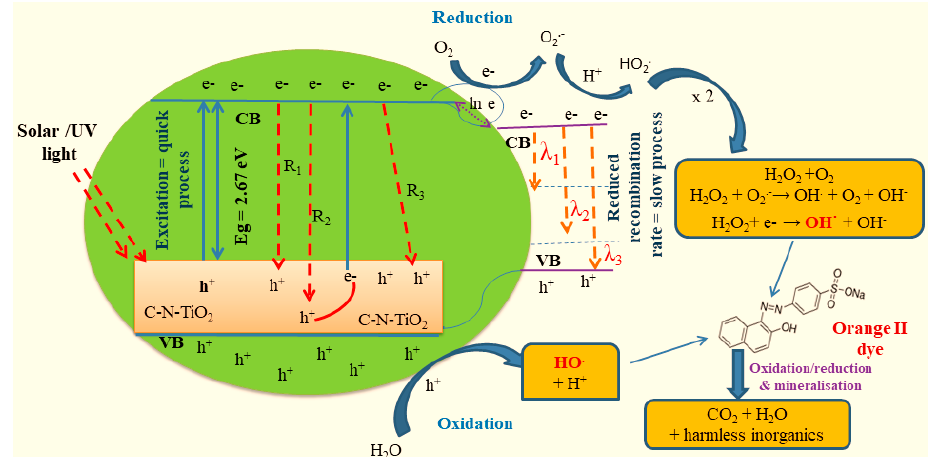
Figure 10. Schematic of photo catalytic and recombination mechanisms for the decolouration of O.II (R 1 , R 2 and R 3 = recombination mechanisms between conduction band (CB) and valence band (VB), ( λ 1 , λ 2 and λ 3 = recombination mechanisms between CB and p empty orbitals of C and N dopants).